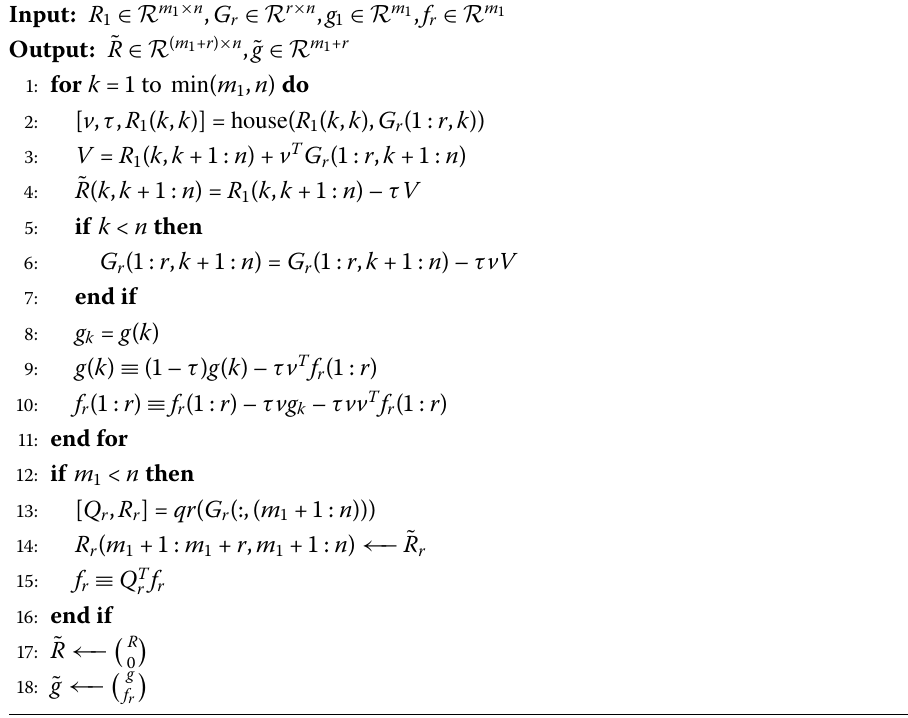
Algorithm  Updating R  factor after appending a block of rows G